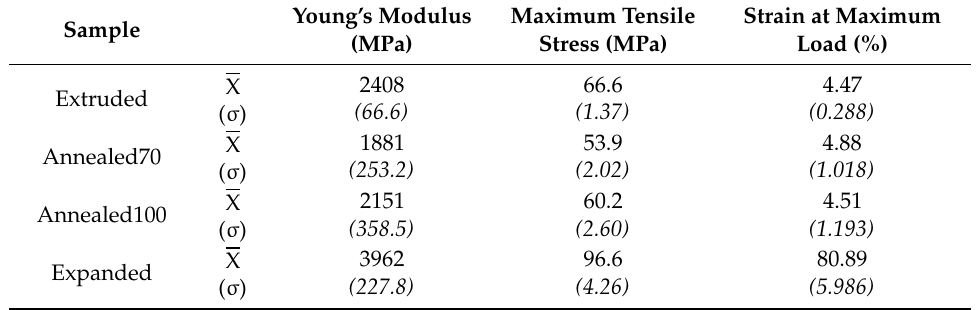
Table 2. Summary of tensile properties from Extruded, Annealed70, Annealed100 and Expanded